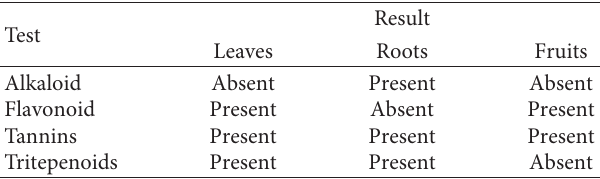
Table 1: Phytochemical analysis of aqueous ethanolic extract of Jatropha gossypifolia